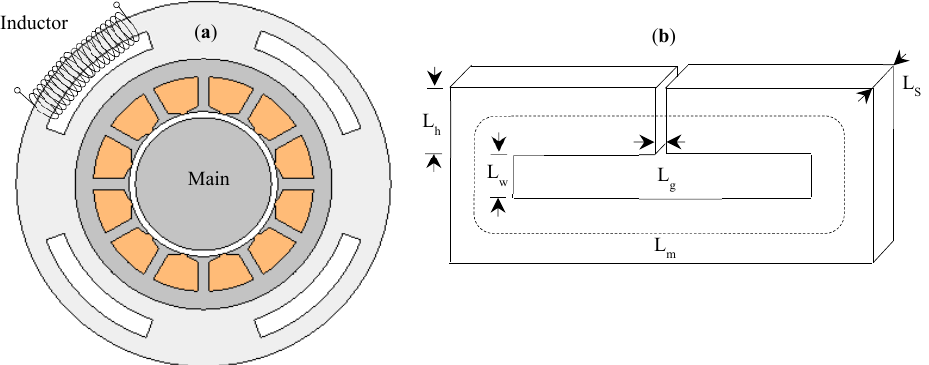
Figure 14. Integrated Inductor ( a ) Motor with integrated inductor wound on the stator back iron ( b ) Approximated Inductor Geometry.